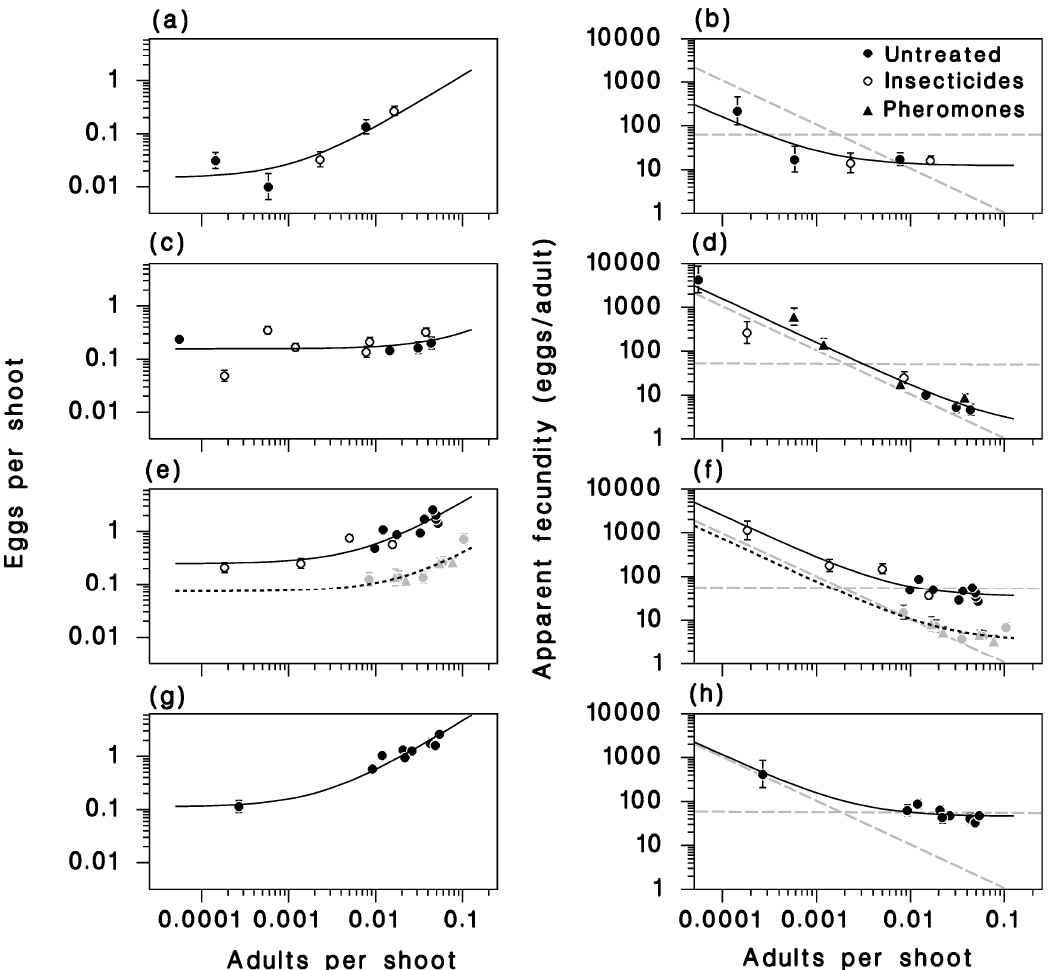
Figure 7. Relationship between resident adult density, egg density field (left column) and apparent fecundity (right column. Lines: Equations (5) (left column) or (6) (right column). ( a , b ): 2012. ( c , d ): 2013. ( e , f ): 2014, dotted lines and grey symbols: SOPFIM sites). ( g , h ) 2015. Grey dashed lines in the right panels represent the extremes of no migration (slope 0) and random distribution of eggs (slope − 1).